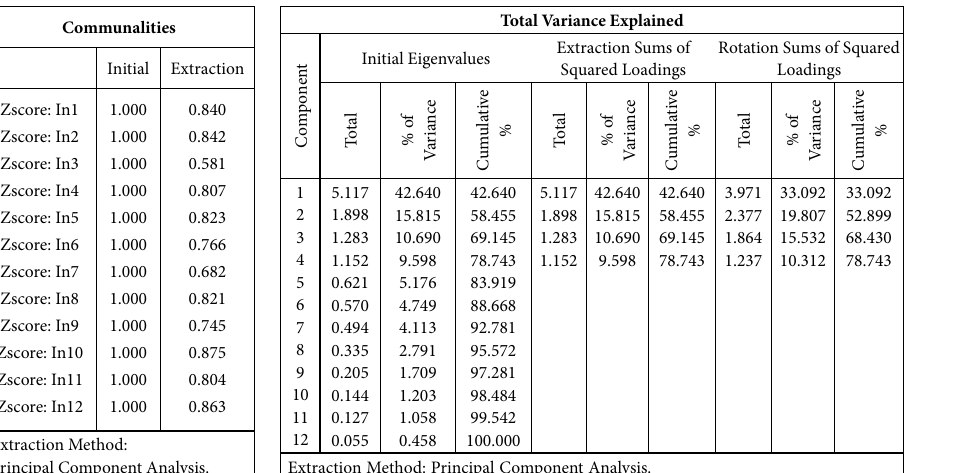
Table 5. SPSS  , Common variance and total variance explained